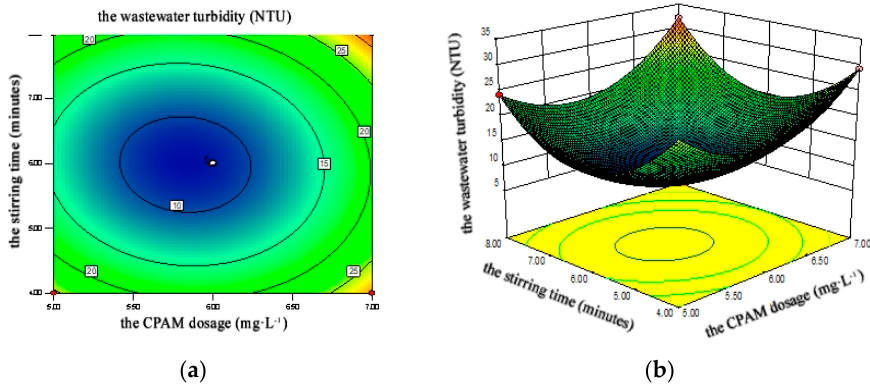
Figure 7. The impact of the interaction between CPAM dosage and stirring time on wastewater turbidity. ( a ) Contour diagram; ( b ) 3D surface diagram.